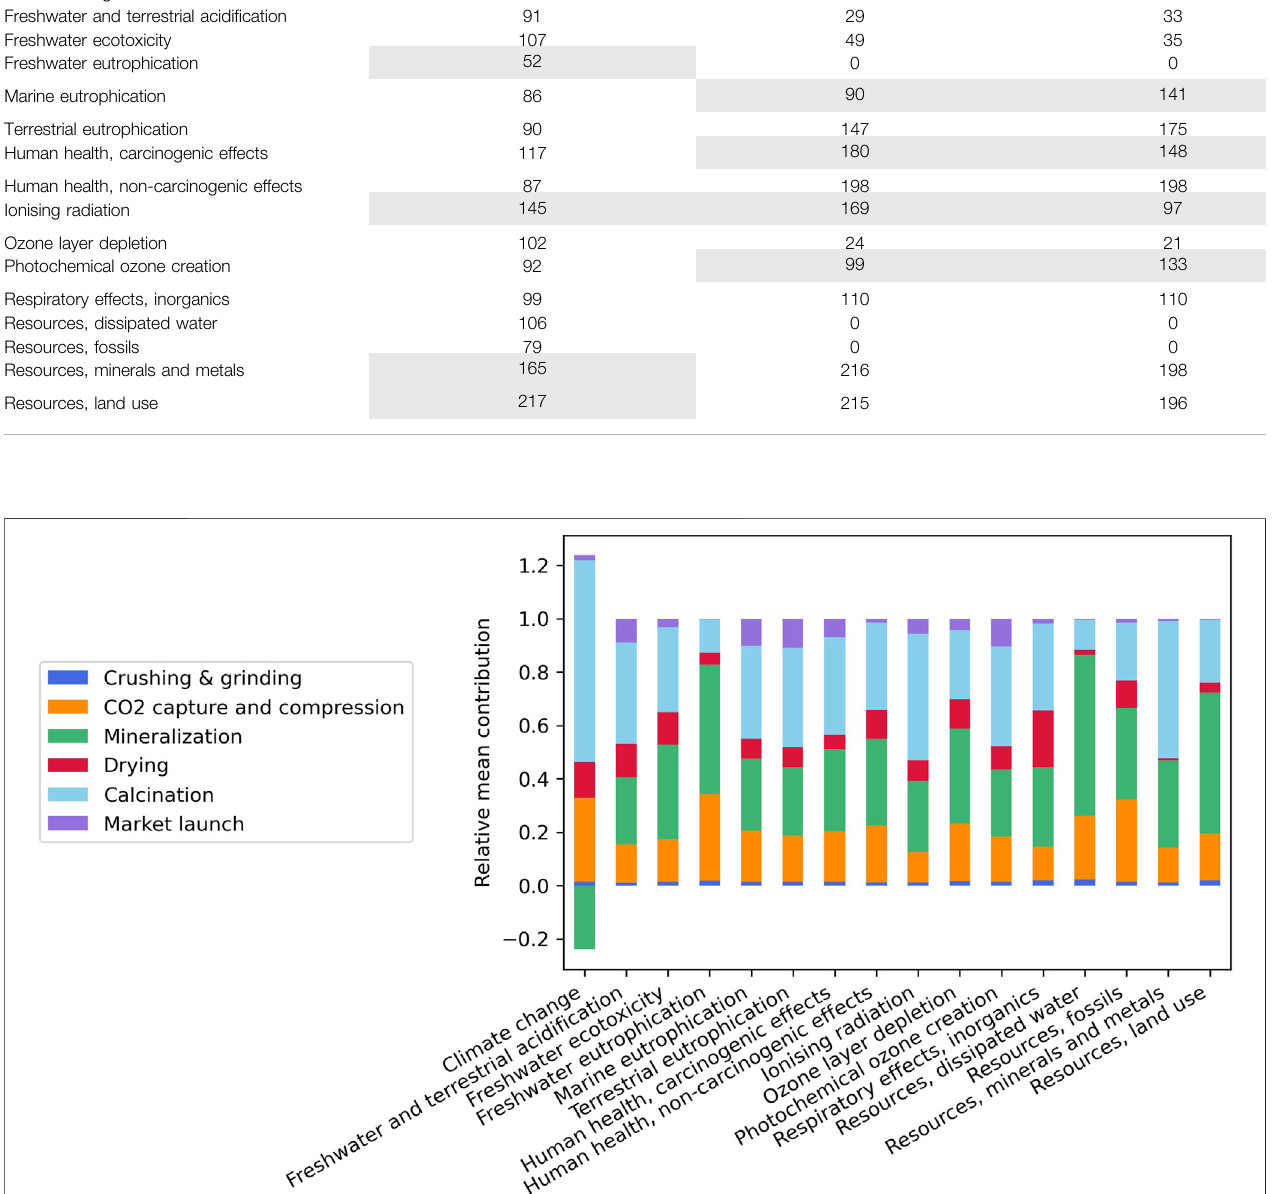
Frontiers in Built Environment |